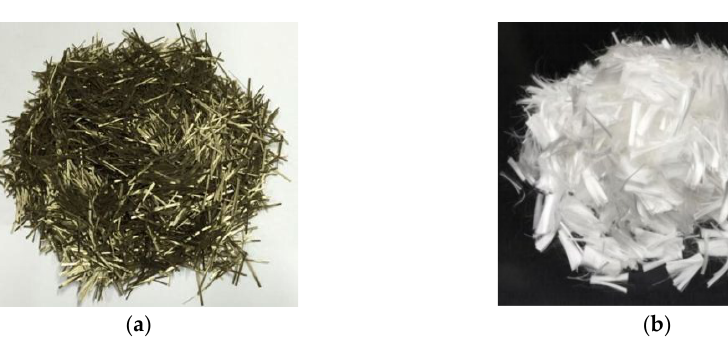
Figure 1. Morphology of fibers: ( a ) basalt fibers; ( b ) polypropylene fibers. Table 3. Physical properties of basalt fiber and polypropylene Table 1. Chemical compositions of gelling materials (kg/m³).